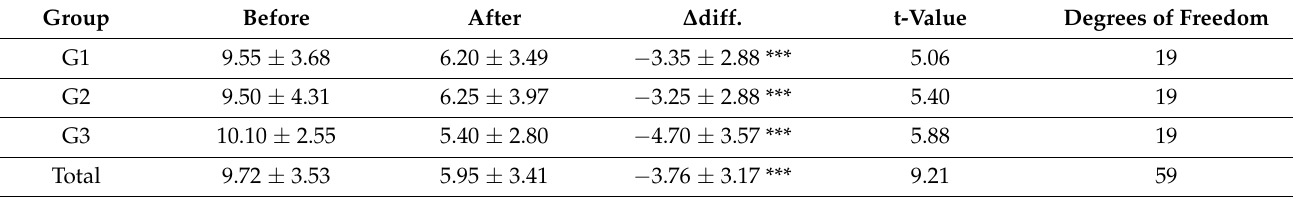
Table 9. The degree of change in the left calcaneal valgus angle in each participant group.